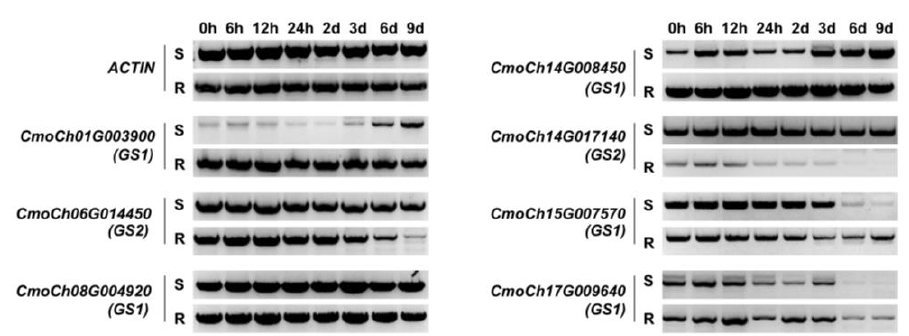
Figure 7. Semi RT-PCR identification of CmoGS expression in responding to cold stress. The time for cold treatment is shown at the top of the figure (h: hour, d: day). Actin: CmoACT7 . S: first true leaf of pumpkin. R: root of pumpkin.